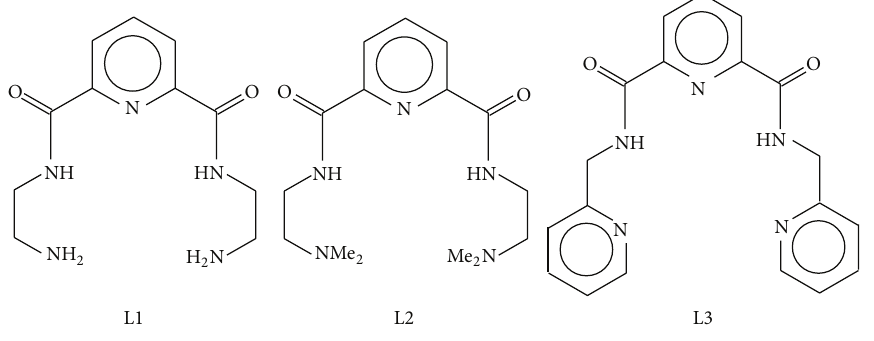
Figure 1: Schematic structures of ligands (L)